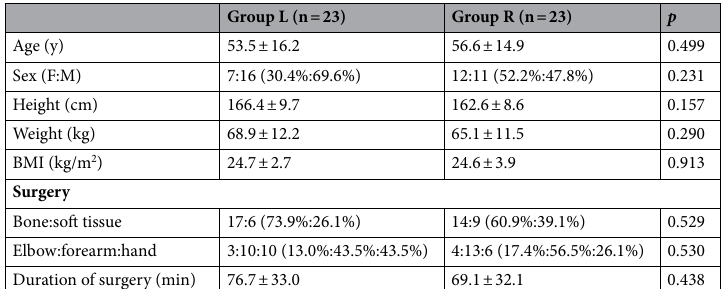
Table 1. Demographic data of the patients. Data are presented as mean ± standard deviation, or number (%).